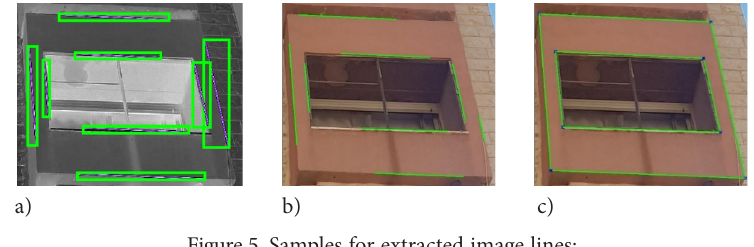
Figure 5. Samples for extracted image lines: